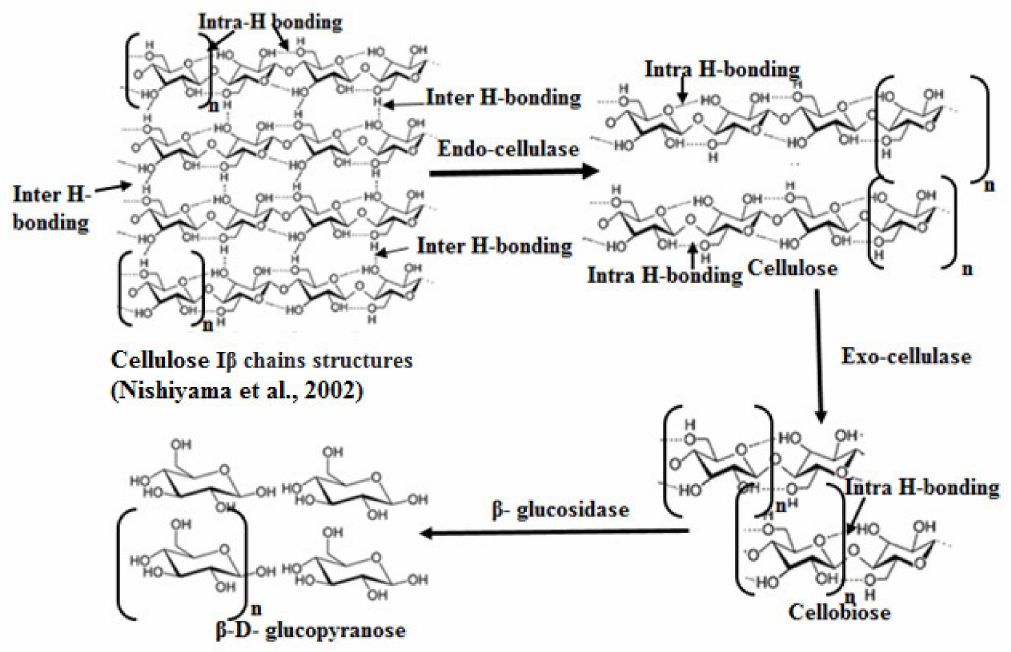
Figure 6. Proposed reactions of different cellulase enzymes on cellulose fibers